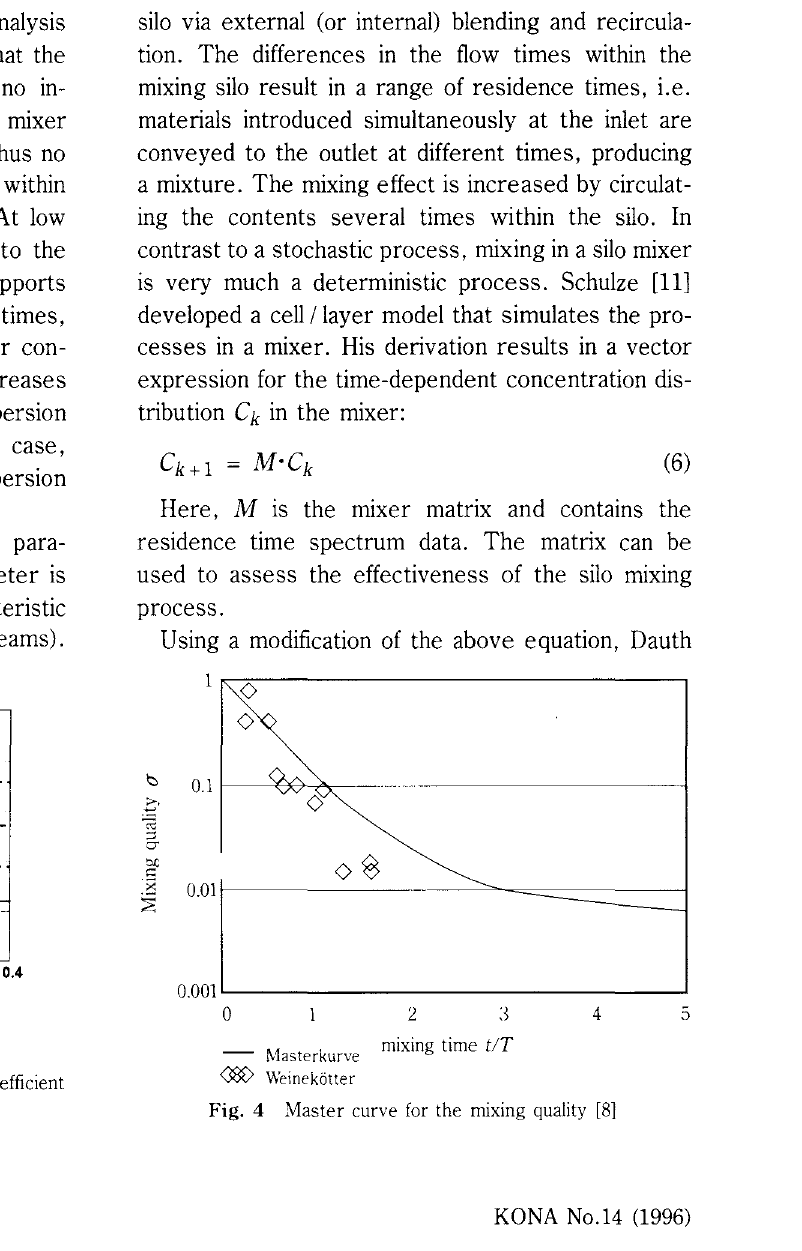
Fig. 3 :vlixing quality as a function of dispersion coefficient D and transport coefficient u Fig. 4 Master curve for the mixing quality